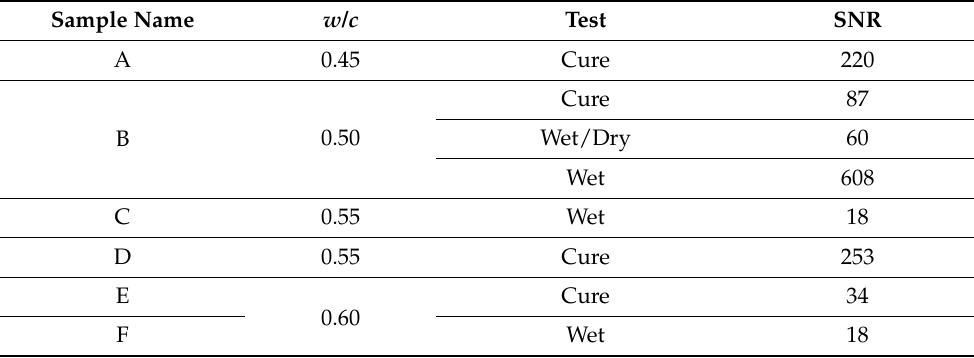
Table 2. Signal-to-noise ratio (SNR) for each of the tests undertaken during this